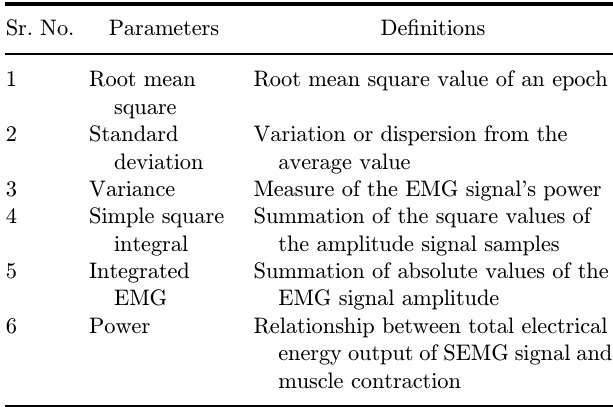
Table 1. Calculated SEMG parameters.